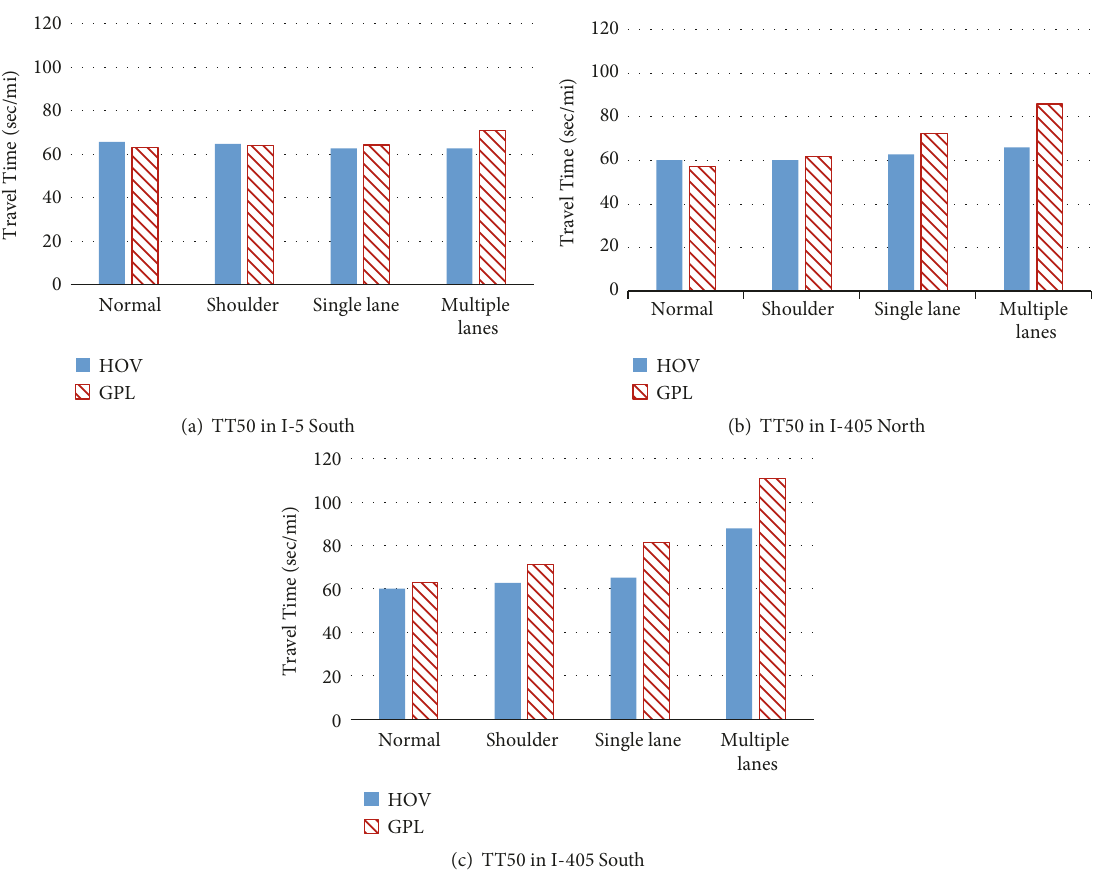
Figure 3: Comparison of 50th percentile travel time between HOV lanes and GPLs in I-5 South, I-405 North, and I-405 South. (a) TT50 in I-5 South. (b) TT50 in I-405 North. (c) TT50 in I-405